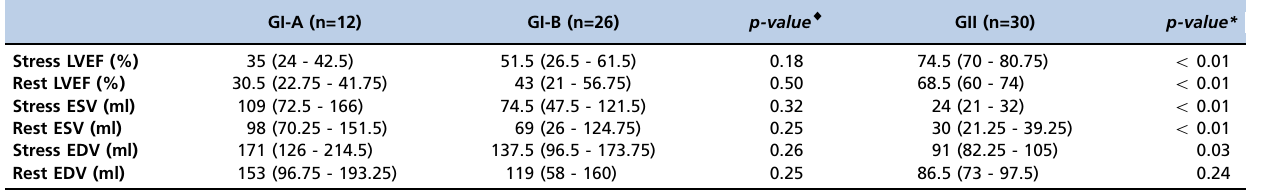
Table 5 - Results of the comparisons of left ventricular ejection fraction between GI-A, GI-B, and GII. GI-A (n=12) GI-B (n=26) p-value ~ GII (n=30) p-value* Stress LVEF